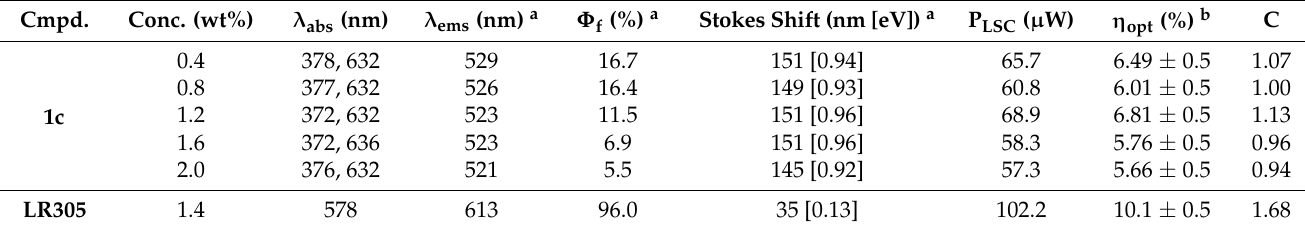
Table 2. Spectroscopic properties and optical efficiency of 1c in PMMA films.